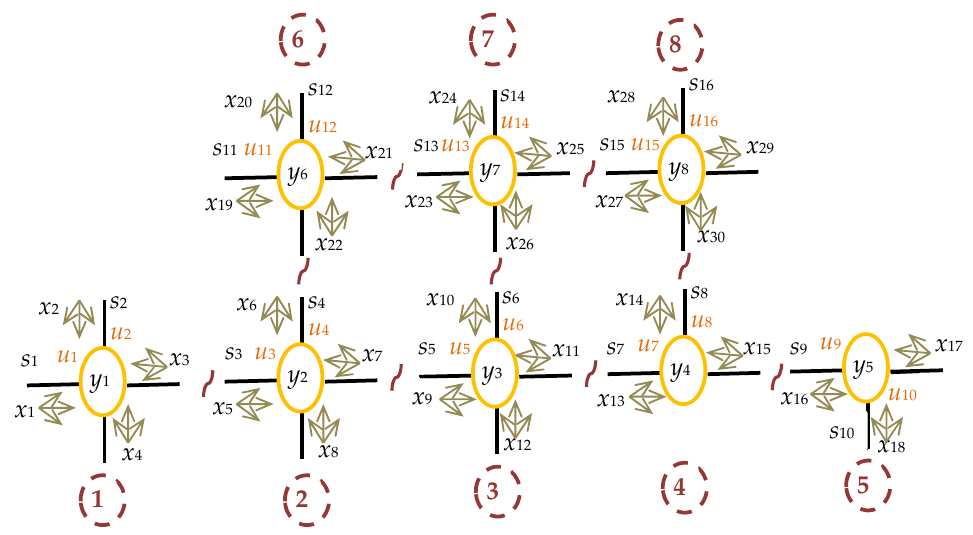
Figure 3. Network topology.